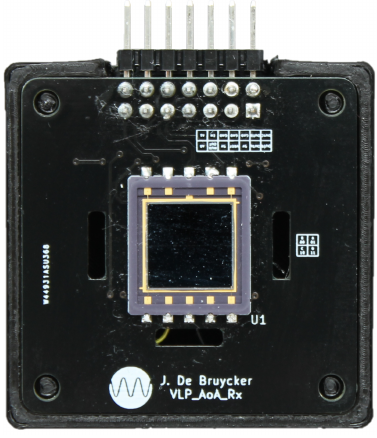
aperture and rotation